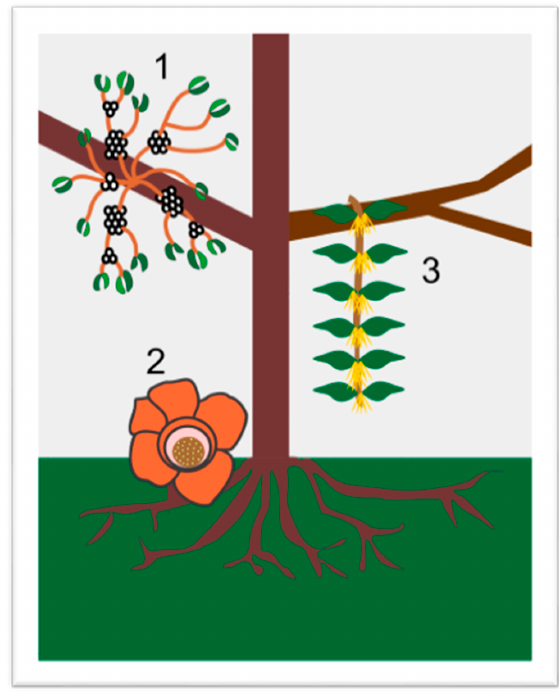
Figure 1. An illustration of aerial parasites. Plant 1 shows Viscum album, also known as European Mistletoe. Plant 2 illustrates a root parasite (i.e., Rafflesia spp.). Plant 3 depicts Scurrula ferruginea , a Southeast Asian mistletoe.